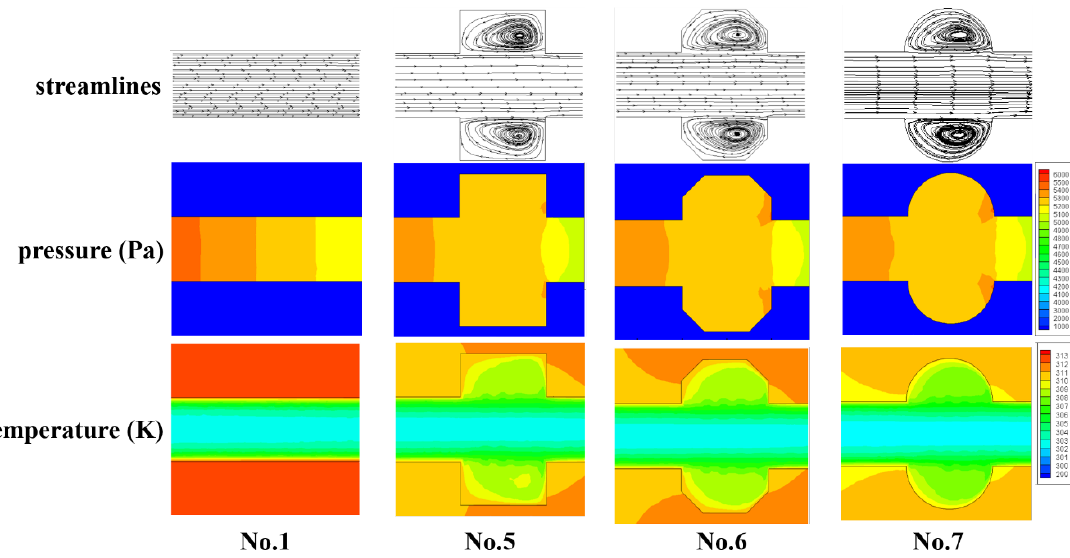
Figure 9. Local streamlines, pressure and temperature distribution of Group 1 and straight microchannel (No. 1).